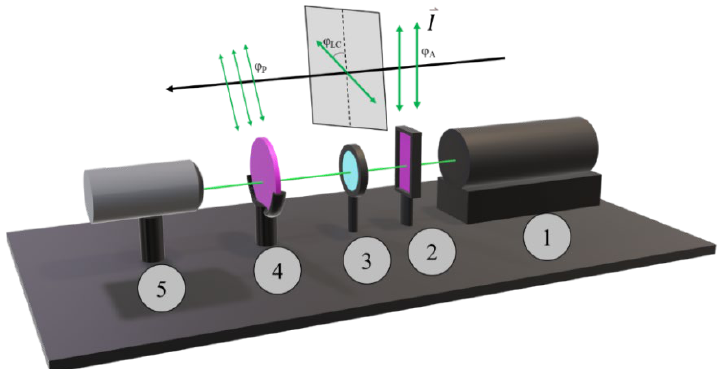
Figure 2. Experimental scheme for the measurement of the light plane polarization rotation: 1—Nd:YAG laser (532 nm); 2—polarizer; 3—tested LC cell; 4—analyzer; 5—photodiode with the